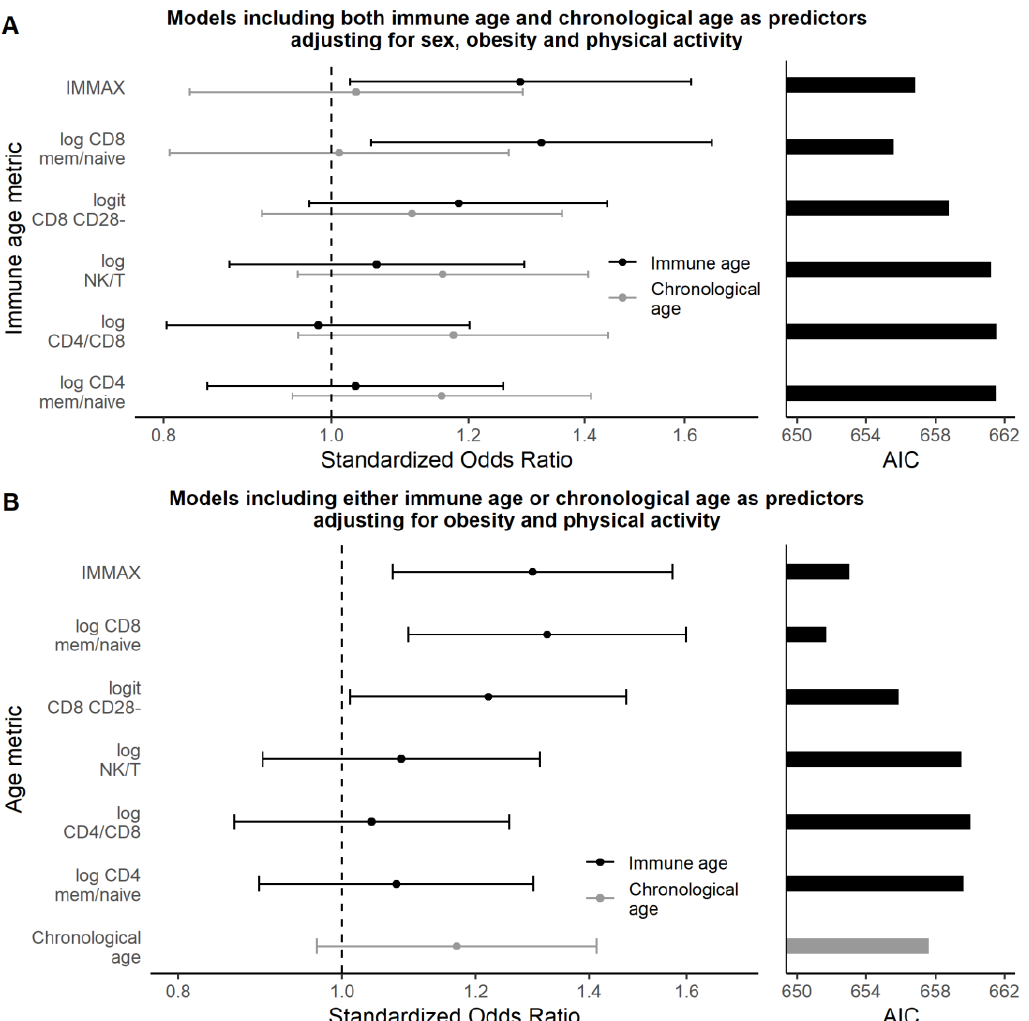
Figure 3. Multiple logistic regression results comparing chronological age with different immune age metrics as predictors of low CRF by standardized odds ratios with 95%-CI (left panels, with vertical dashed reference lines indicating null effect) and by Akaike’s information criterion AIC with lower values indicating improved model fit (right panels), respectively. ( A ) Results using different immune age metrics as predictors in separate models in addition to chronological age, adjusting the analyses for sex, obesity, and physical activity. ( B ) Results using either chronological age or different immune age metrics as predictor in separate models, adjusting for obesity and physical activity, but excluding sex as covariate.